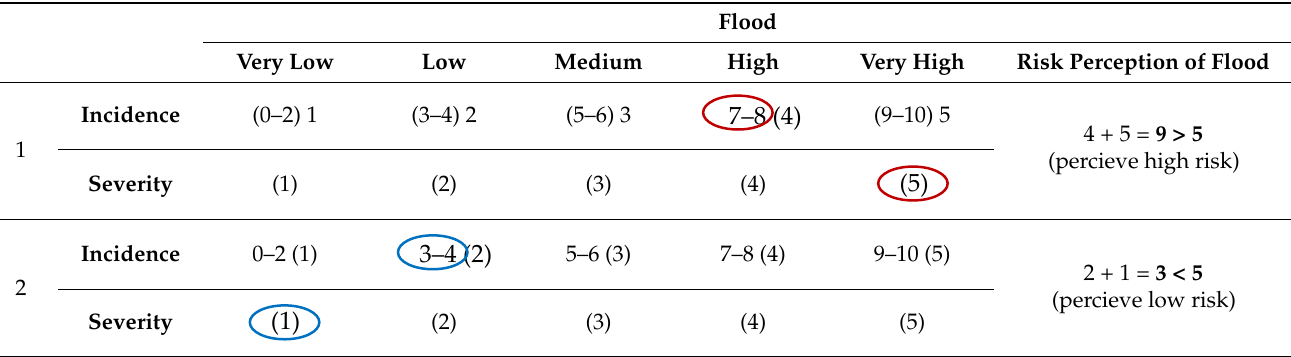
Table 2. Scores of farmers’ risk perception of each weather-related risk.